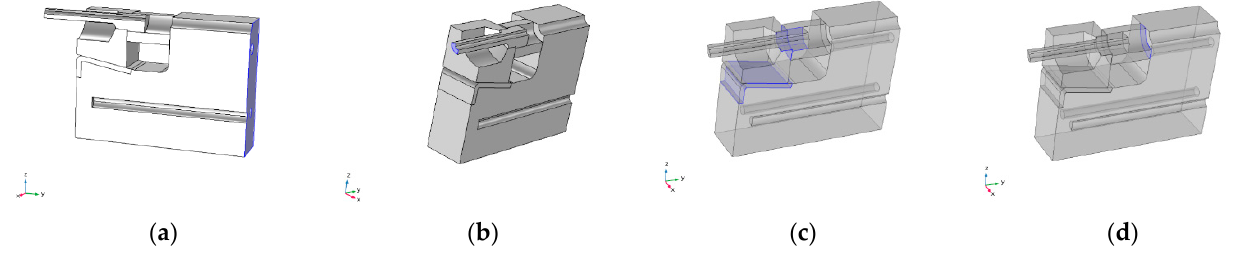
Figure A4. ( a ) Surfaces for current arrival, ( b ) Surfaces for mass, ( c ) "strong" electrical contact surfaces, d) "weak" electrical contact surfaces.